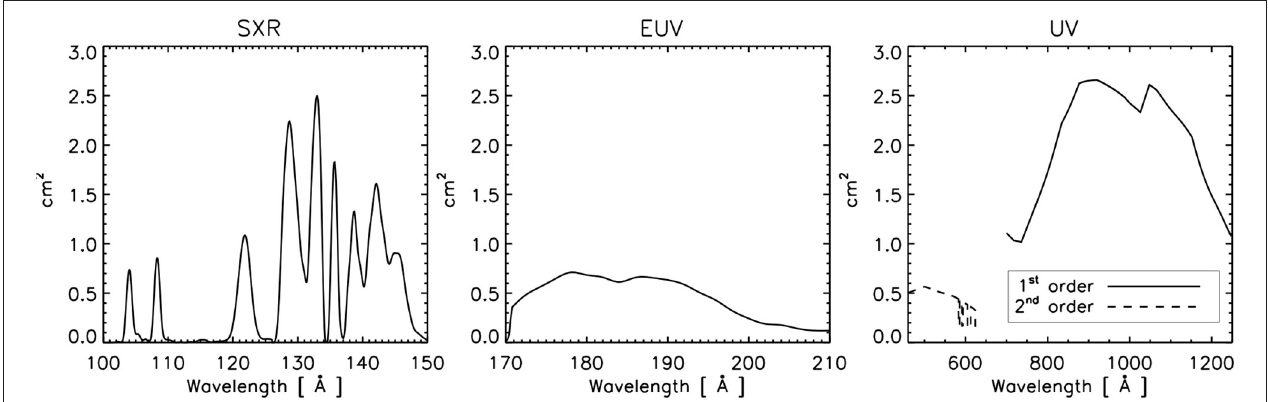
FIGURE 4 | Effective areas for the soft X-ray channels (left), with those of a scaled-down version of the LEMUR instrument in the EUV/UV (see text).